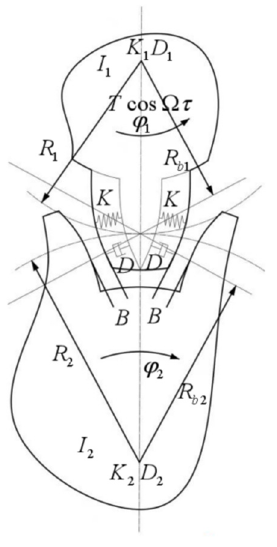
Figure 1. Diagram of gear pair with backlash.